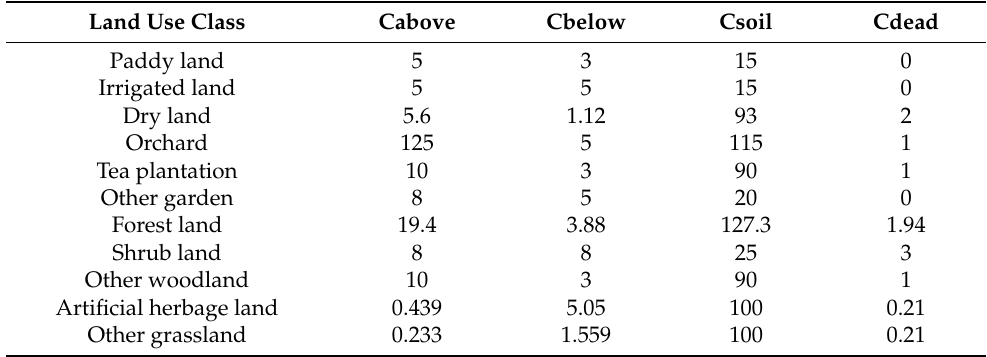
Table 2. Biomass and soil carbon density (Mg/ha) in different land use